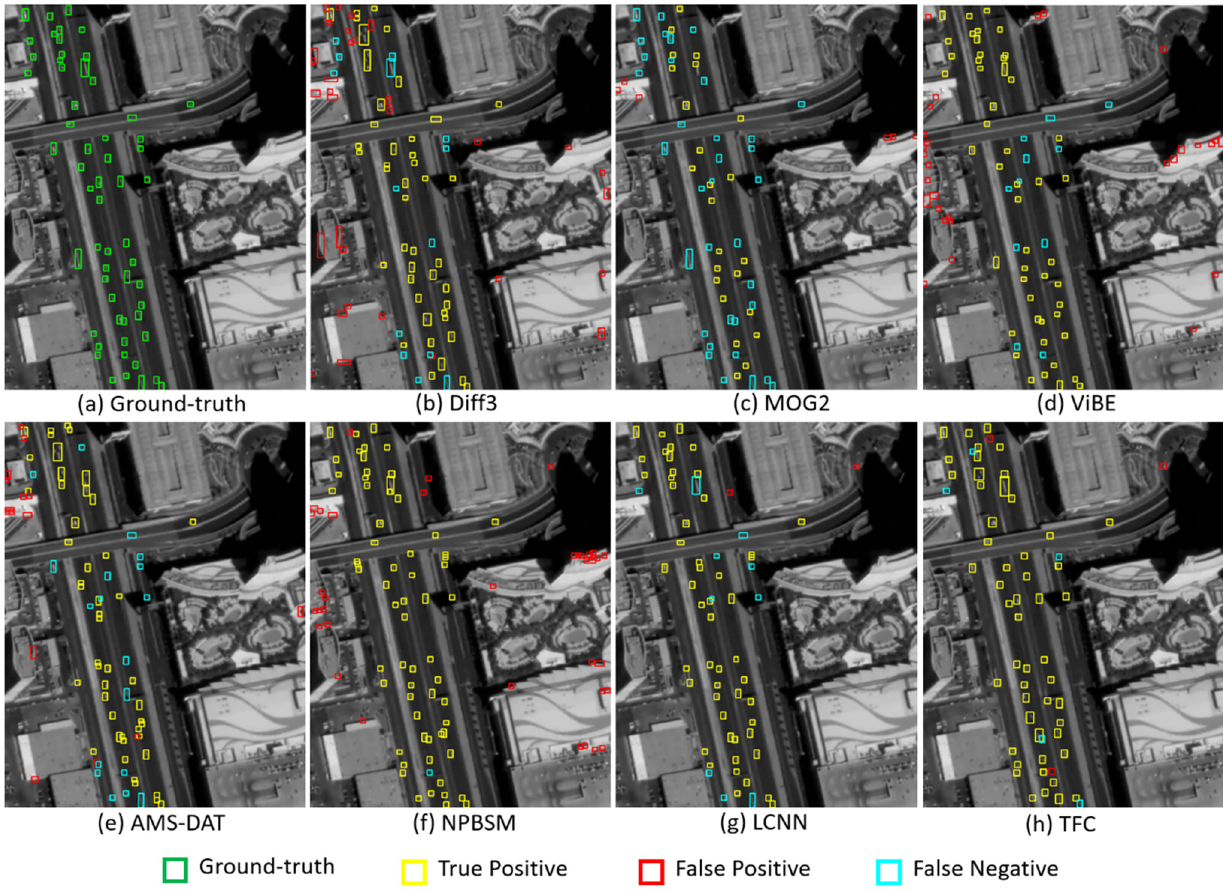
Figure 12. Detection of Dataset 1: yellow indicates correct targets, red shows false targets, and cyan depicts missed targets. Panels ( a ) Ground ‐ truth, ( b ) Diff3, ( c ) MOG2, ( d ) ViBE, ( e ) AMS ‐ DAT, ( f ) NPBSM, ( g ) LCNN, and ( h ) TFC (the proposed method).